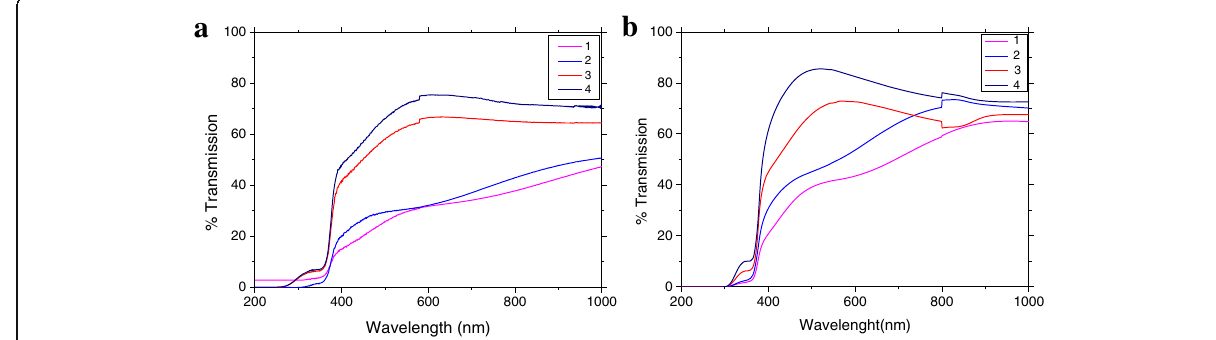
Fig. 5 Optical transmission of the samples ( 1 PLD, 2 PLD-200A, 3 PLD-300, and 4 PLD-400) thin film ZnO as-growth ( a ) and annealed ( b